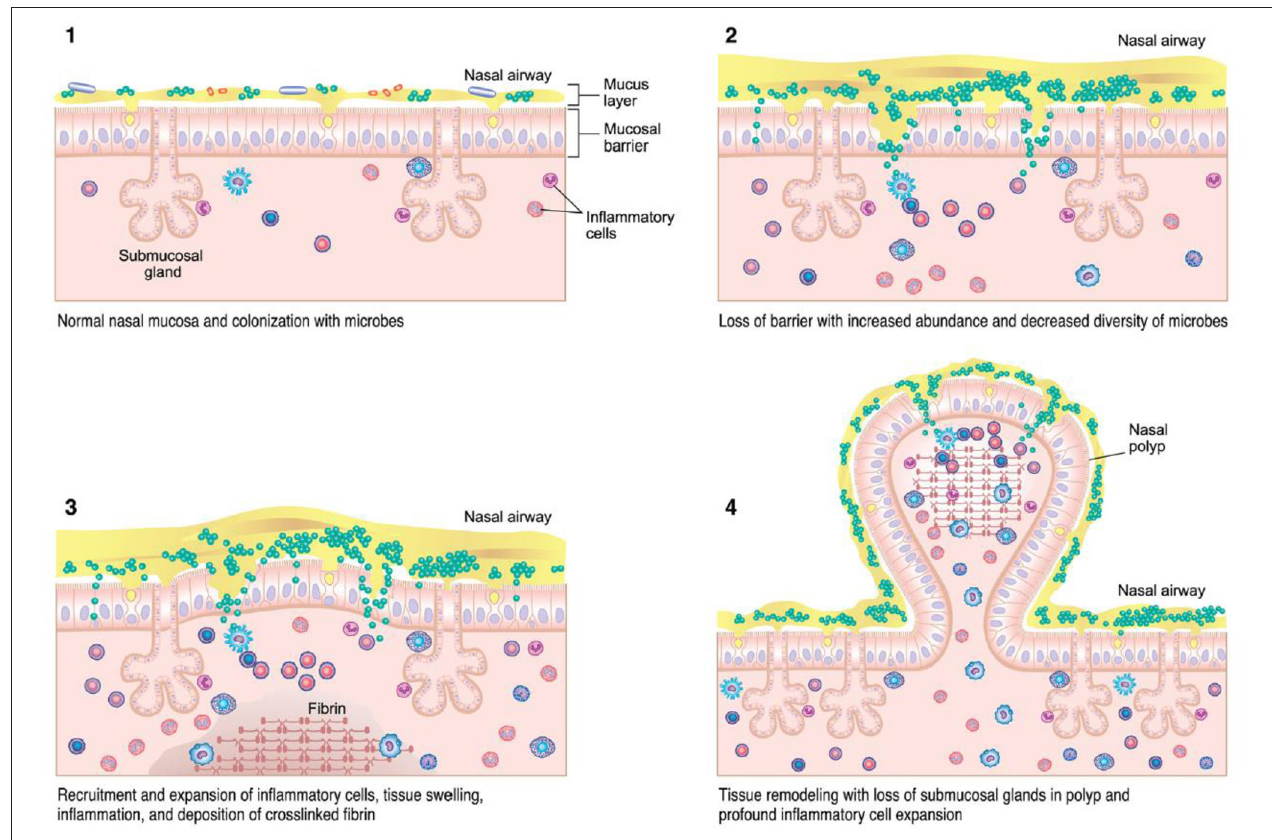
FIGURE 2 | CRSwNP immunopathogenesis (13) – colonization of microbes with accumulation of immune cells can lead to tissue injury, inflammation, and mucosal barrier loss in